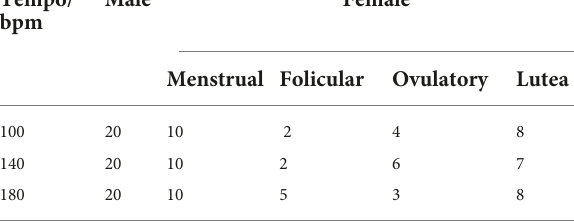
TABLE 1 Number of male and female subjects participating in the Stroop-experiment under the influence of different tempi. Tempo/ Male Female bpm